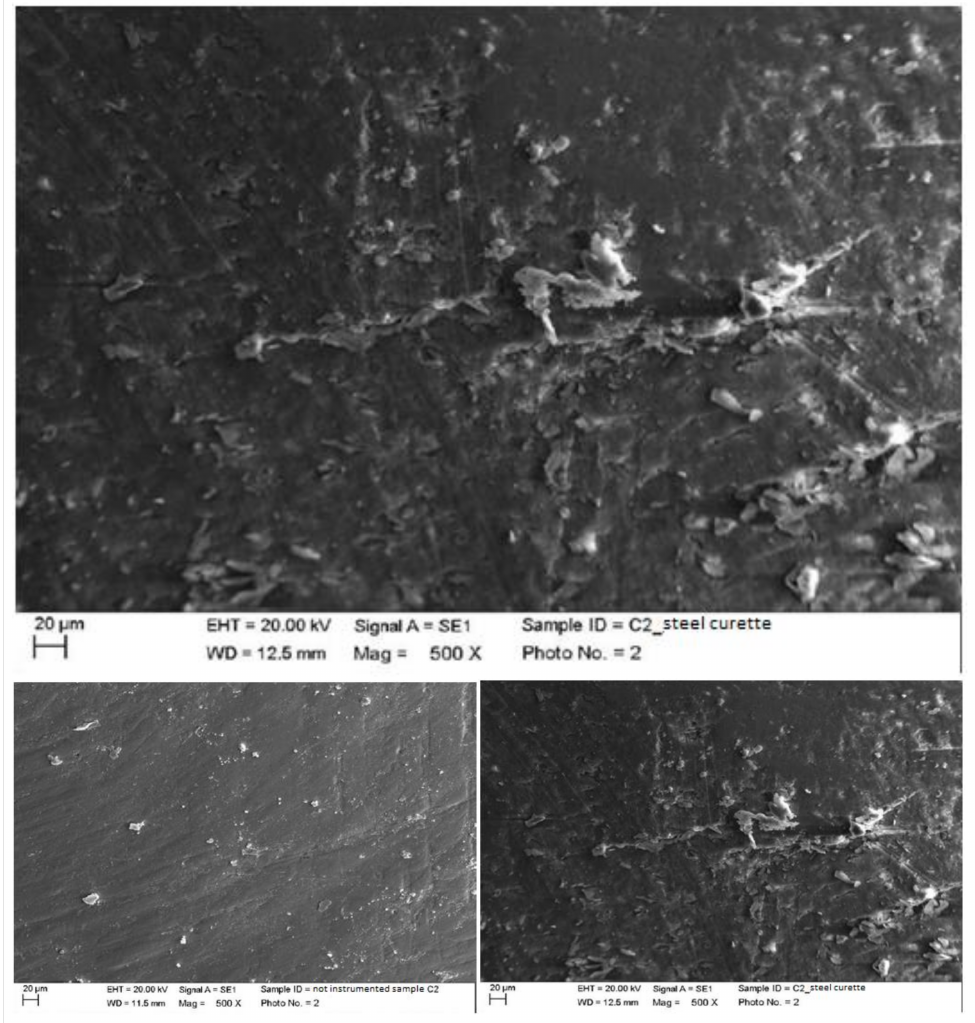
Figure 8. Instrumented composite sample C2 with steel curette (500 × ). Comparison before/after